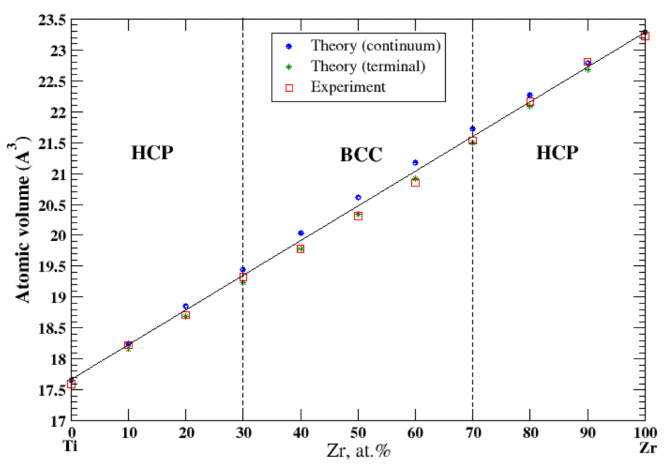
Figure 21. Atomic volume vs. concentration for Ti-Zr alloy system. The experimental data are from Ref. [16] (p. 873 and p.